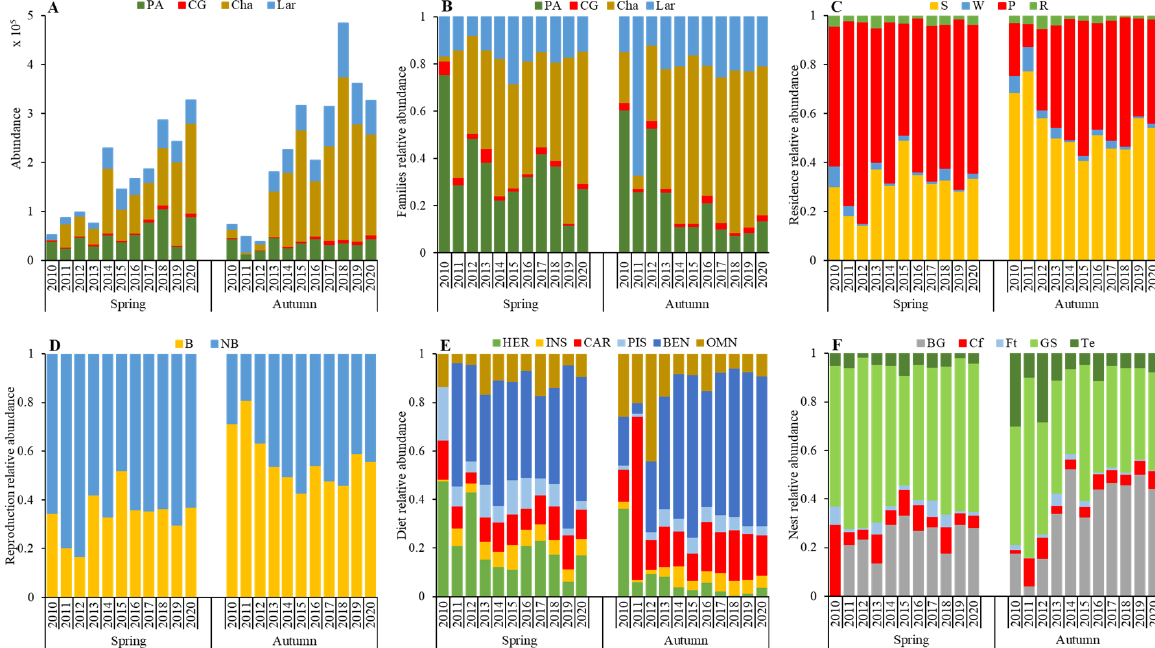
Figure 2. Total abundance of 74 common waterbird species in spring and autumn from 2010 to 2020, and relative species abundance of different categories; ( A ): abundance; ( B ): Podicipediformes, Anseriformes, and Pelecaniformes (PA), Ciconiiformes and Gruiformes (CG), Charadriiformes (Cha), and Lariformes (Lar); ( C ): summer visitor (S), winter visitor (W), passage (P), and residence (R); ( D ): breeding (B) and nonbreeding (NB); ( E ): herbivores (HER), insectivores (INS), carnivores (CAR), piscivores (PIS), benthivores (BEN), and omnivores (OMN); and ( F ): bare ground (BG), cliff (Cf), float (Ft), grass and shrub (GS), and tree (Te).